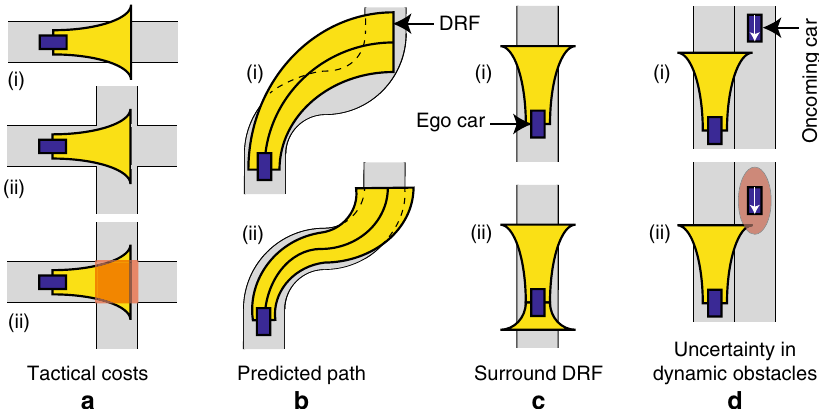
Fig. 6 Limitations of the model. a Tactical costs: The DRF model can only perceive physical risk from objects such as cars, trees, etc. However, it cannot perceive the risk from oncoming traf fi c which is currently not in its fi eld of view. Hence, at an intersection, rather than slowing down, it will speed up, since there is larger road-area available, which is contrary to what a human would do. This can be solved by introducing additional ‘ tactical costs ’ that arti fi cially increase the risk of an intersection (red square). This approach can be extended to other elements such as traf fi c lights or zebra crossings. b Predicted path: For simplicity, the DRF model currently uses a circular arc for predicting the path (for preview time t la seconds). This circular path arises due to the assumption that the current steering angle ( δ ) and speed ( v ) will be held constant over the preview time. However, we can optimise for a vector of steering angles and speed (as is done in a Model Predictive Control). This allows for a fl exible DRF and better prediction of microscopic trajectories. c Surround DRF: In this paper, the DRF only extends in front of the vehicle (top). However, the risk fi eld extends on all four sides. The bottom image is merely a suggestion, and the shape has not been investigated. This ‘ surround DRF ’ will help predict human-driving behaviour in additional scenarios such as: being followed by another car, being overtaken, lane change manoeuvres, etc. d Uncertainty in dynamic obstacles: The DRF represents the driver ’ s (self) perception-action uncertainty. However, the motion of dynamic obstacles is less predictable. This uncertainty was ignored in this paper, but will have to be accounted for in future iterations of this